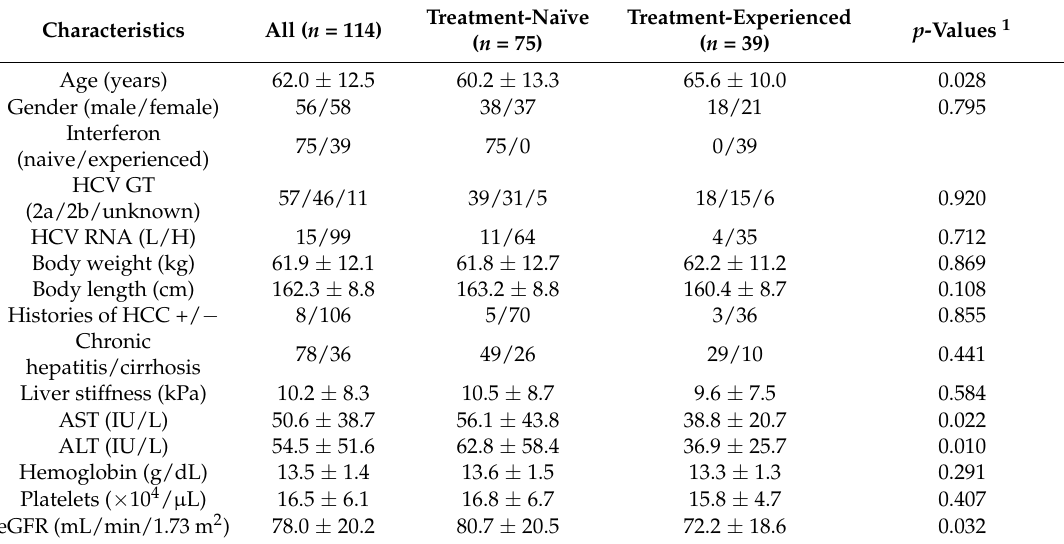
Table 1. Characteristics of 114 hepatitis C virus (HCV) genotype (GT)-2 patients at the commencement of